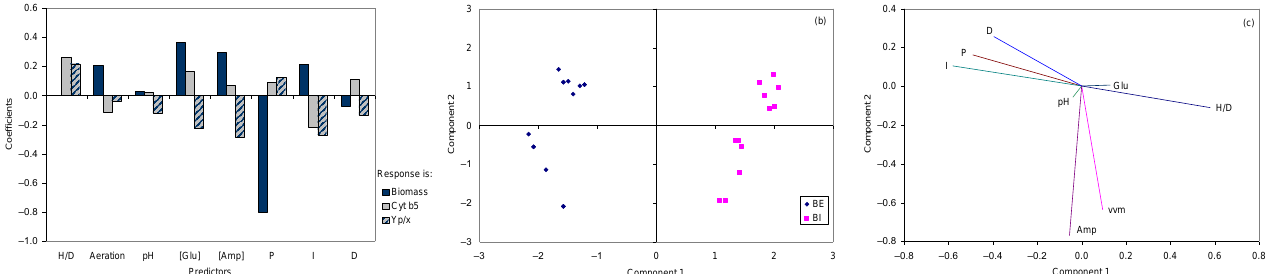
Figure 7. Partial least squares analysis. ( a ) Regression coefficients using as response biomass and cyt b5 concentrations, and